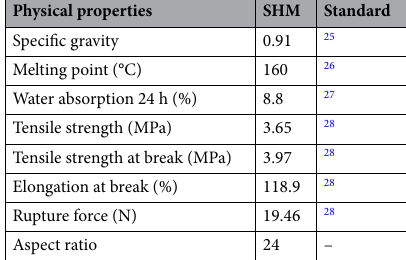
Table 4. Physical properties of healthy personal protective materials (HPPM) from Shabrian et al. 24